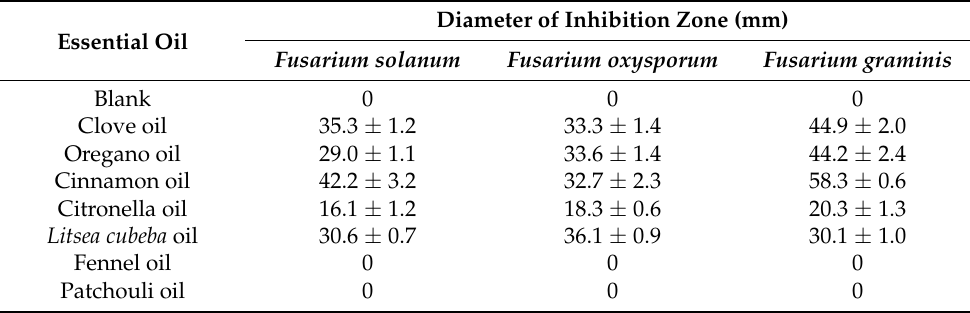
Table 2. Inhibition zone diameter of seven essential oils against Fusarium strains.